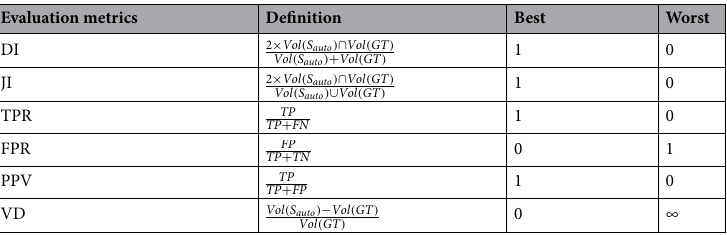
Table 1. The six evaluation metrics are chosen from the conventional and well know evaluation parameters presented in the MICCAI grand challenge and literature. The Dice index (DI), Jaccard index (JI), and volume difference (VD) are used to measure the quality of WML segmentation by calculating their volume and Euclidean distance of WML boundary. Whereas, the true positive rate (TPR), false positive rate (FPR) and positive predictive value (PPV) usually practice understanding the quality of WML detection. The notations for Vol ( S auto ) is volume of WML segmented by automated method, Vol ( GT ) is volume of WML delineated by neuroradiologist, TP is number of true positive, FP is number of false positive, FN is number of false negative, and TN is number of true negative. The best is defined as perfect segmentation and worst is completely missed